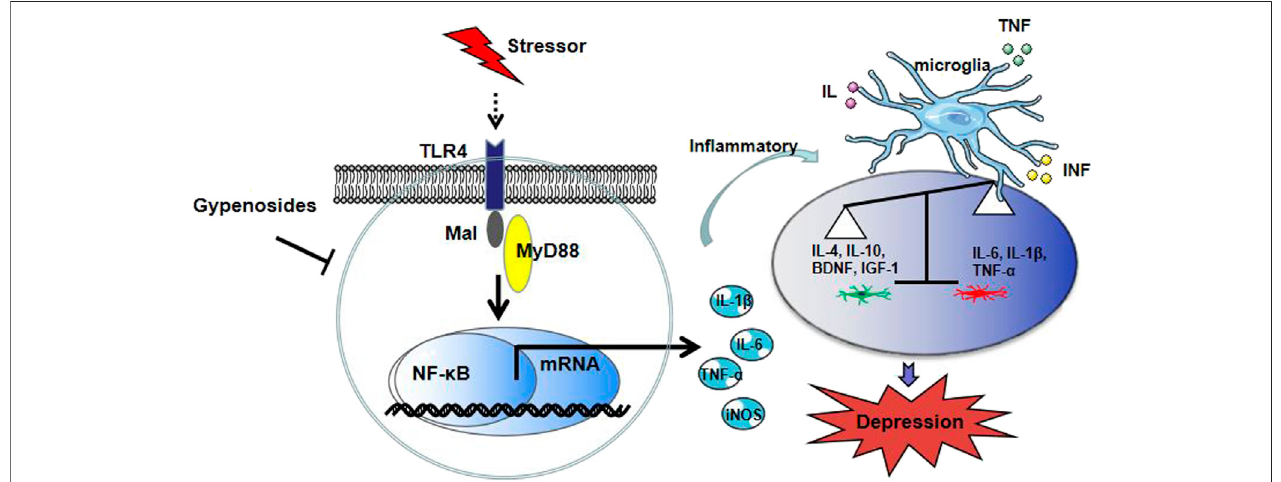
FIGURE 8 | Proposed model depicting our fi nding on Gps blockade of depression-like behavior in